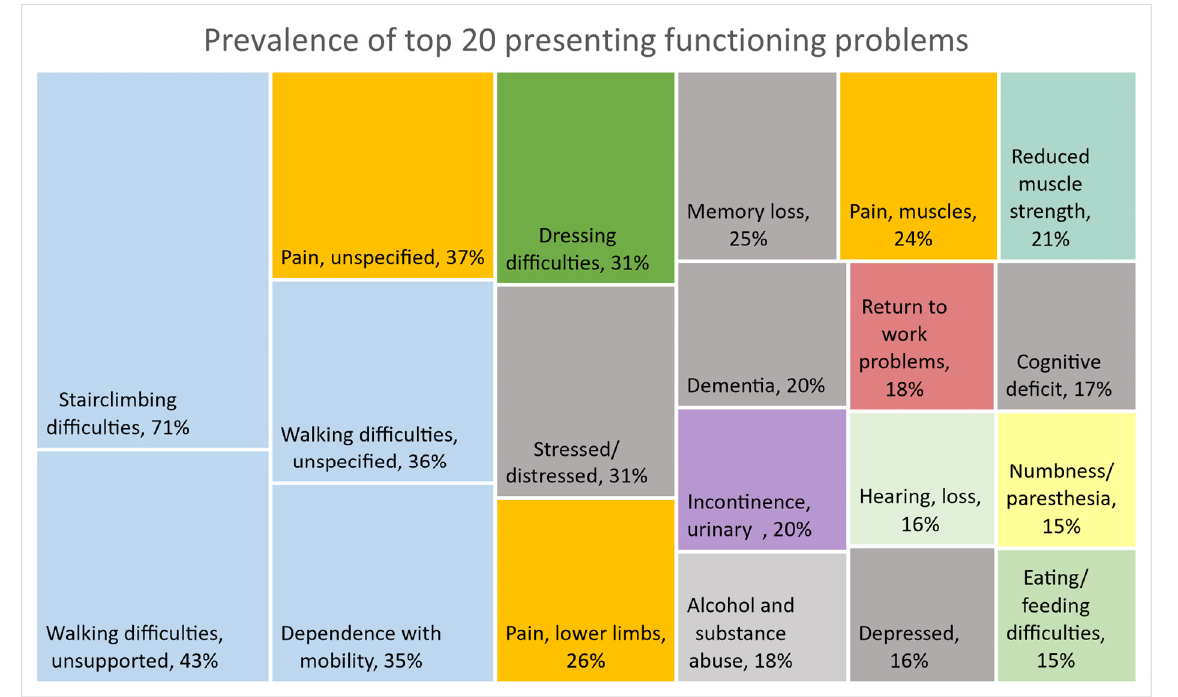
Figure 2. Prevalence (calculated if statistics from at least five articles were available) of top 20 functioning problems from at least 5 articles.